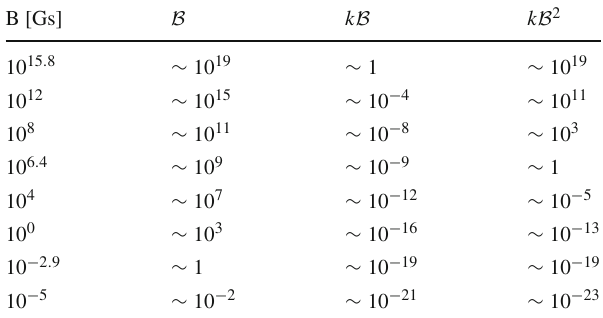
Table 3 Magnitudes of different forces acting on radiating charged particle in the dimensionless form of Eq. (32) for different values of magneticfieldstrengths,comparedtothegravitationalforceoftheorder of ∼ 1. The estimates correspond to a relativistic electron in vicinity of a stellar mass BH with M = 10 M (cid:4)